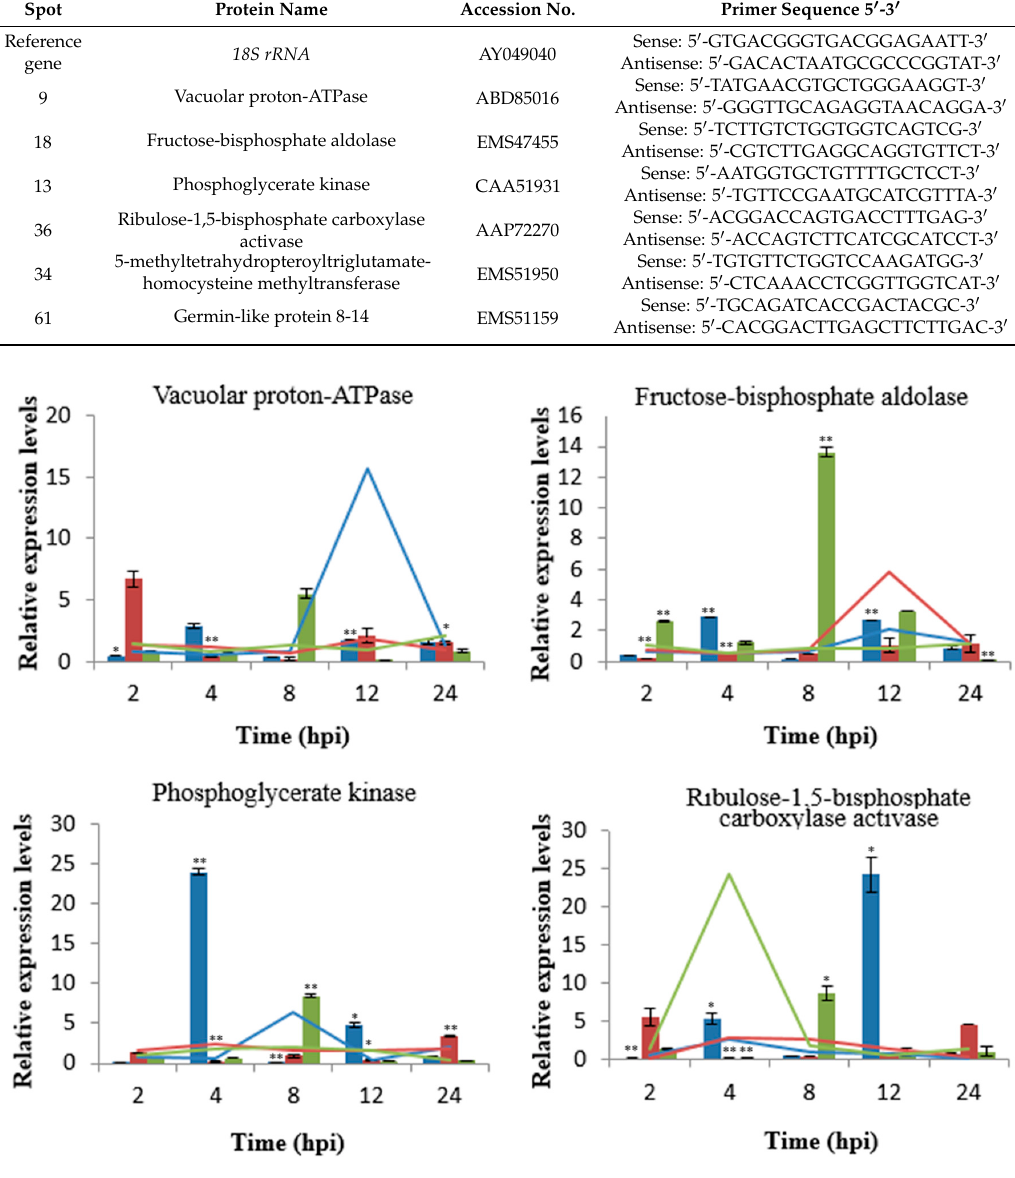
Figure 7. Quantification of six gene transcripts and protein levels at different time points post inoculation with Bgt in wheat. The bar graph shows the fold changes of the mRNA expression levels in inoculation vs control samples at five time points. The blue, red, and green columns are representatives of wheat L699 , Neimai836 , and Chuannong26 , respectively. The lines show the fold changes of the protein expression levels in inoculation vs control samples at five time points. The blue, red, and green lines are representatives of wheat L699 , Neimai836 , and Chuannong26 , respectively. The mRNA expression levels were quantified by qRT-PCR normalized against 18S rRNA . Asterisks indicate statistically significant differences (*, p < 0.05; **, p < 0.01) of mRNA expression levels between the inoculation and control samples. 3. Discussion